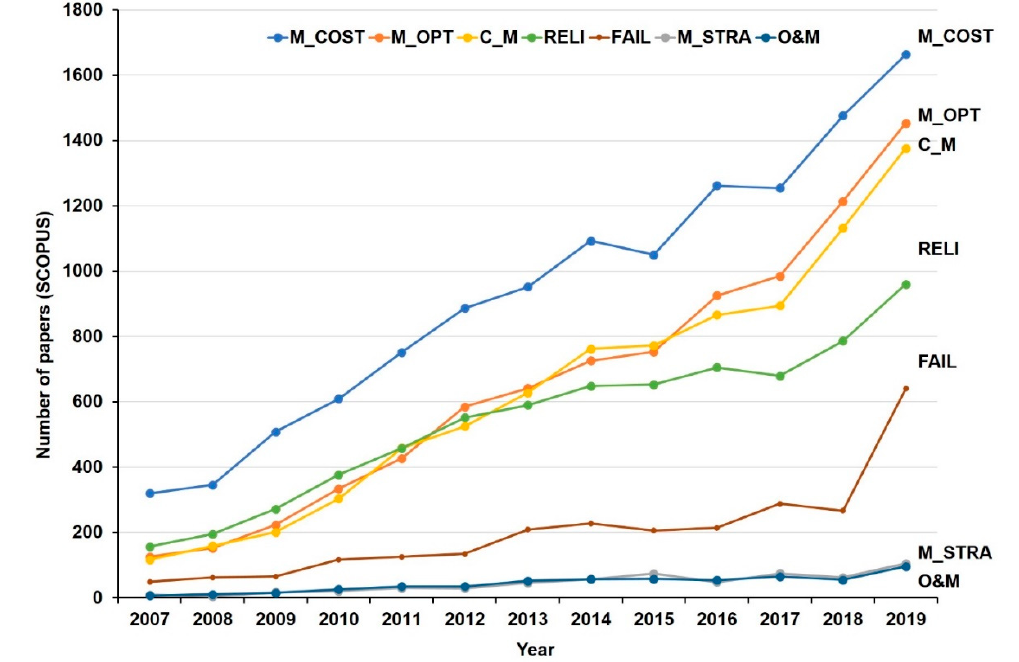
Figure 3. Wind energy O&M cost fields: number of papers in